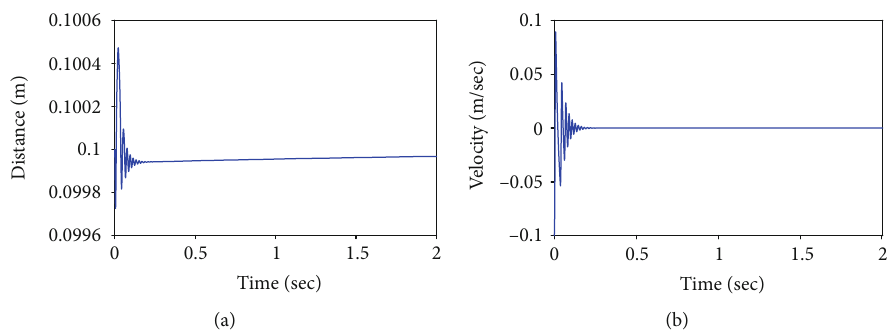
Figure 7: Dynamic response of two contact objects ( stiffness = 0 , damping = 500 ): (a) relative distance of S and S . 2